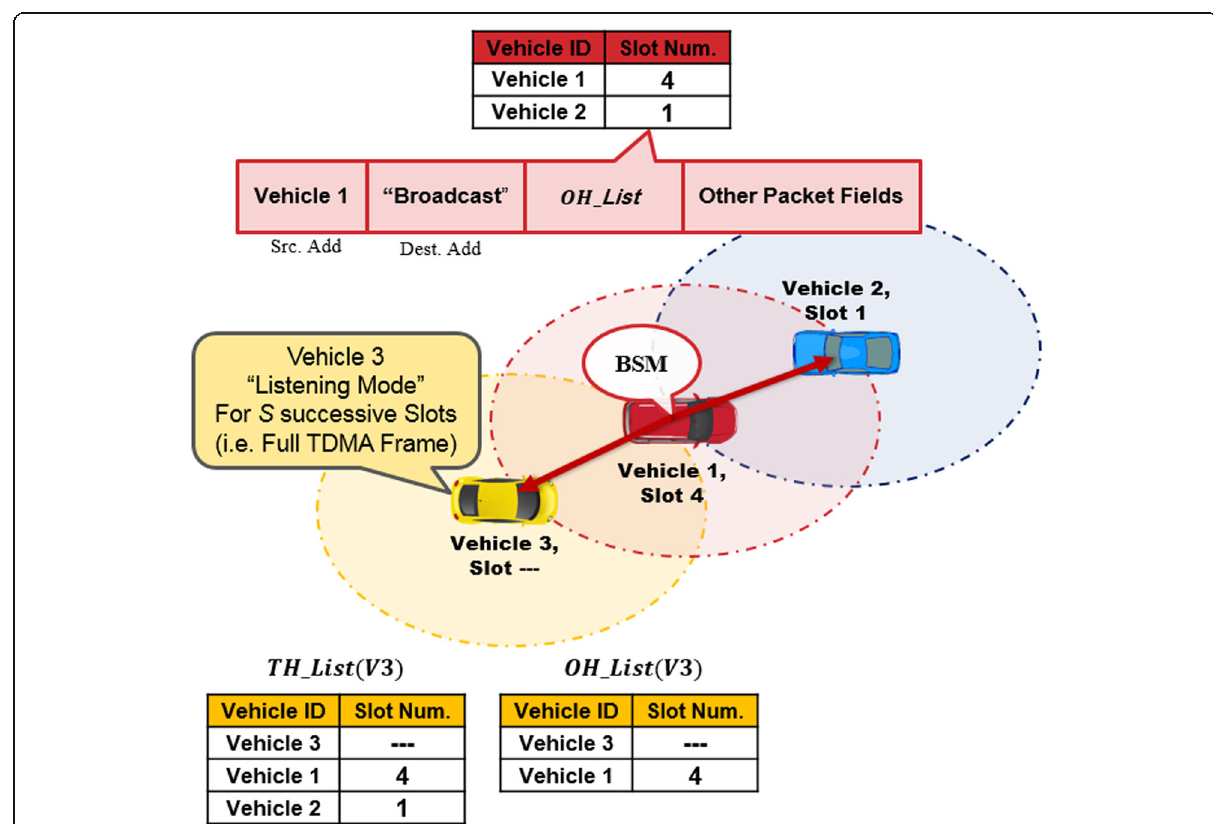
Fig. 4 An example of how each vehicle acquire time slot in the start-up